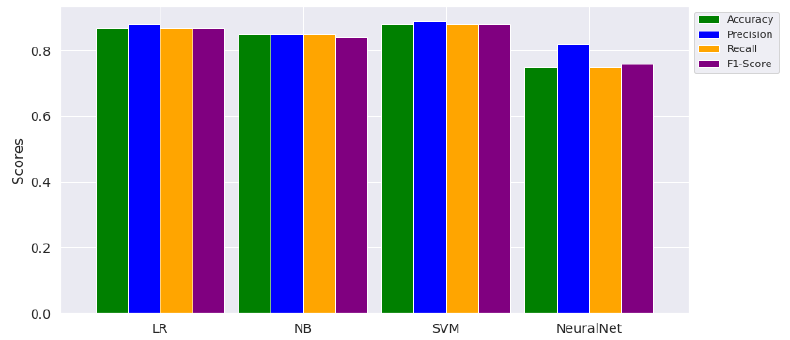
Figure 5. Comparing Performance of Topic Classifiers.